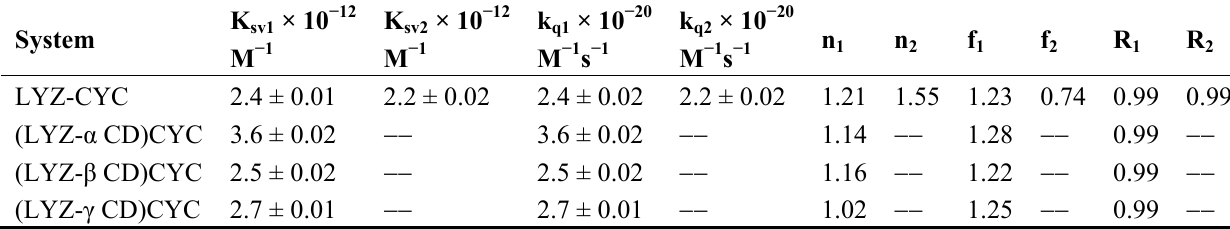
Table 1. The values of Stern-Volmer quenching constants (K (n), fractional of accessible protein (f) and correlation coefficient (R) in the binary and ternary systems at λ = 280 ex